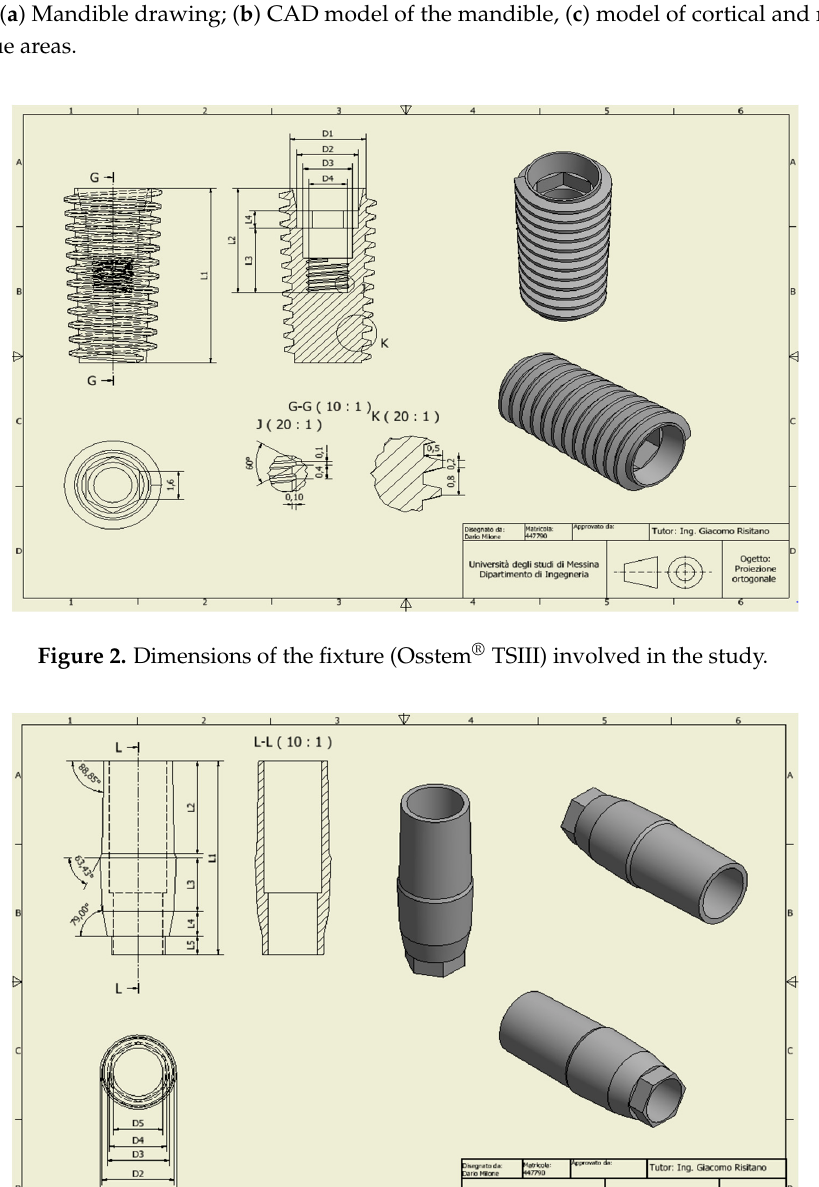
Figure 3. Dental implant abutment chosen accordingly with the connection system of the implant selected for the study.